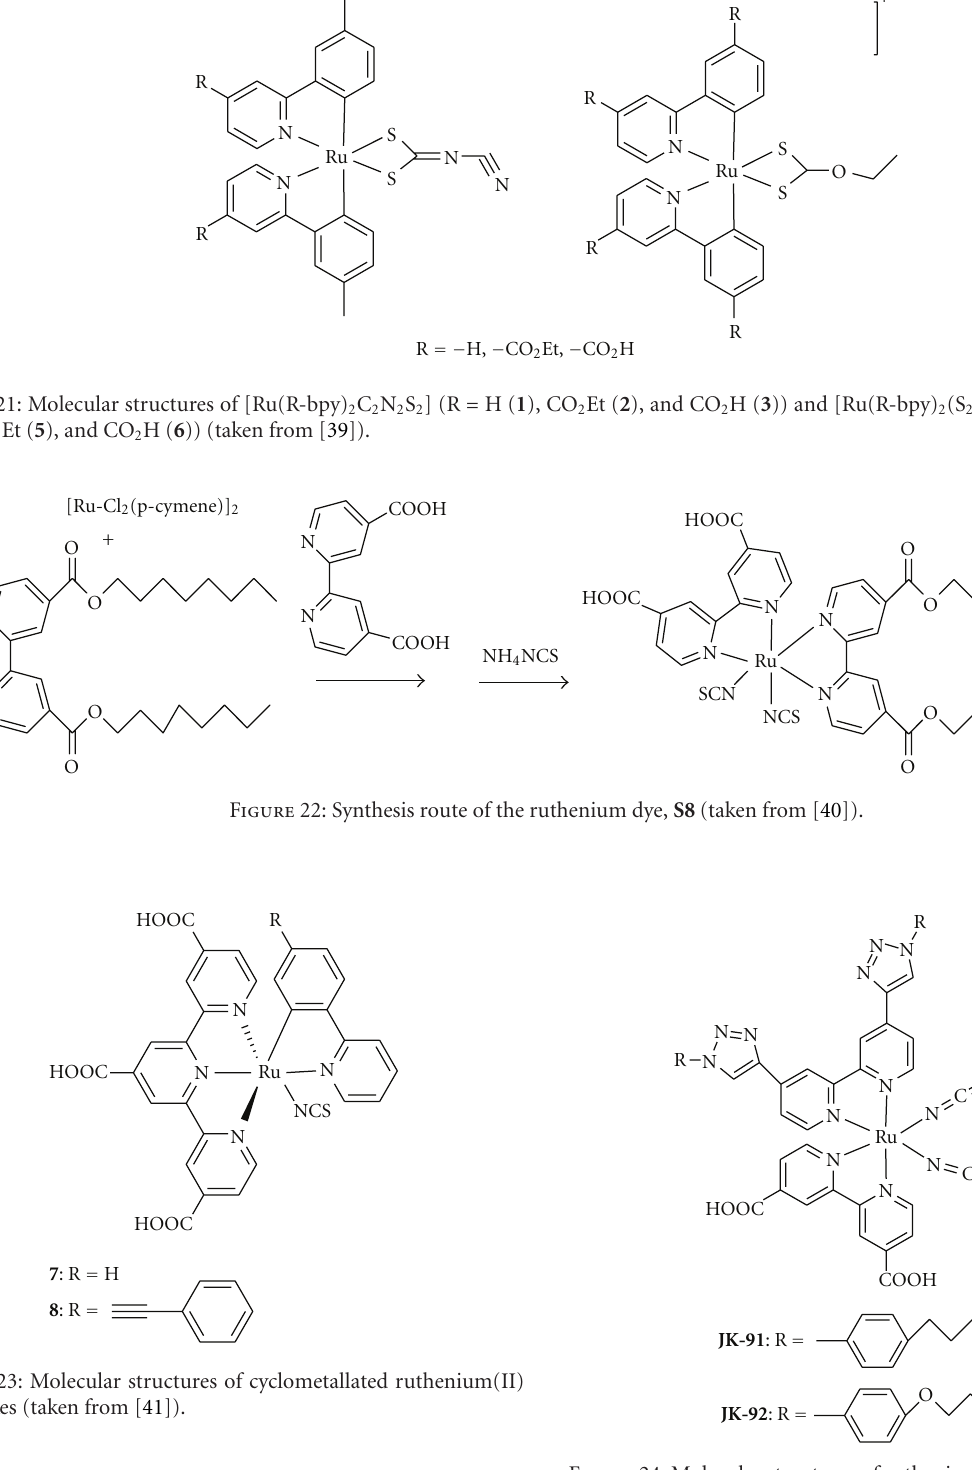
Figure 24: Molecular structures of ruthenium(II) complexes JK-91 and JK-92 (taken from